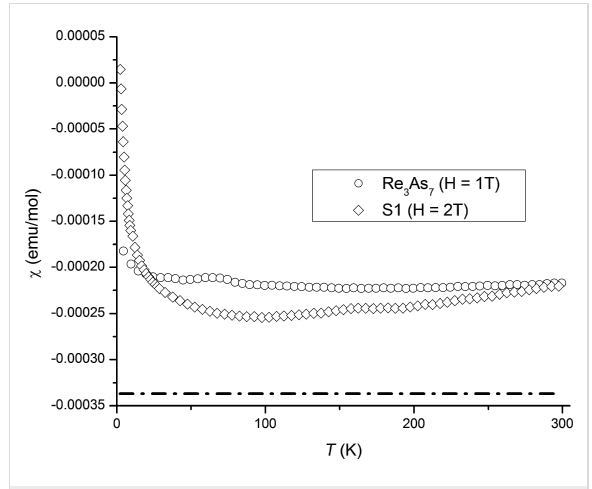
Figure 6: Magnetic susceptibility-versus-temperature plots for the Re 3 As 7 and S1 samples. The contribution of core diamagnetism is shown as a dash-dotted line.